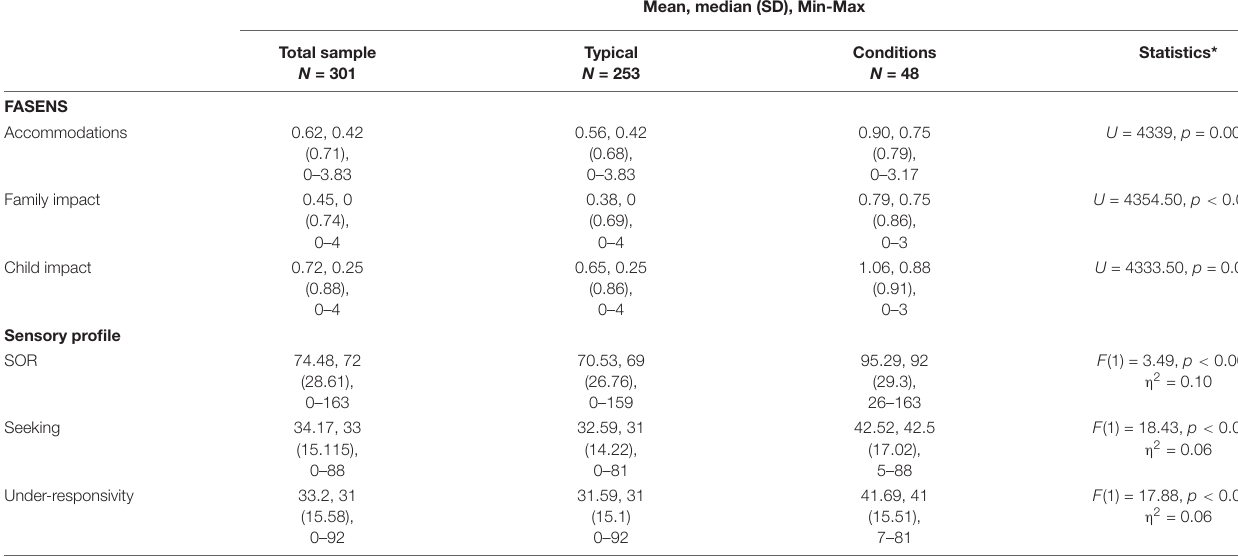
FIGURE 1 | Confirmatory factor analysis model. TABLE 2 | Sensory profile and FASENS scores with group